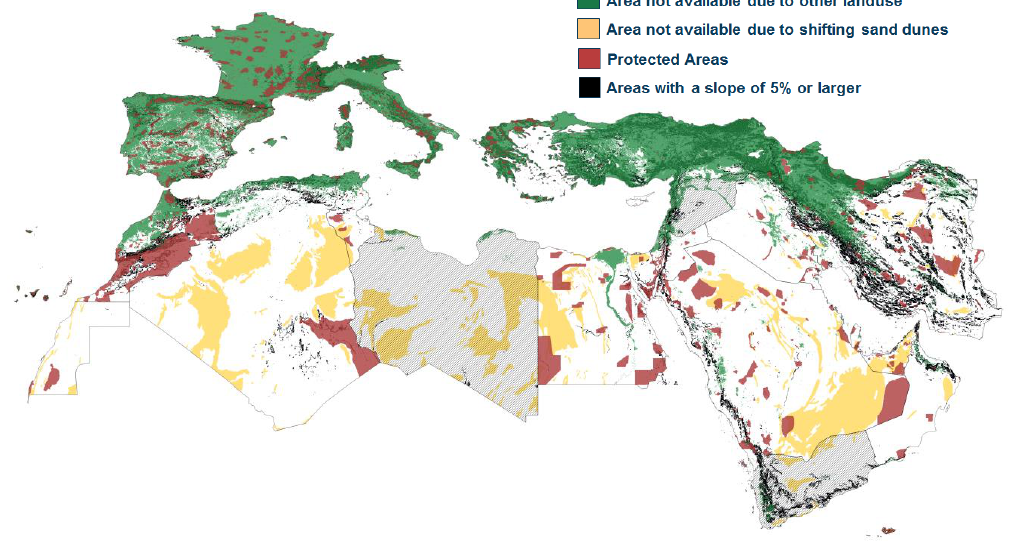
Figure 4. Suitable areas for solar thermochemical fuel production in the MED region. Excluded areas comprise other land use ( green ), protected areas ( red ), ≥ 5% slope ( black ), and shifting sands ( yellow ). Libya, Syria, and Yemen are excluded from the analysis due to missing socio-economic data.